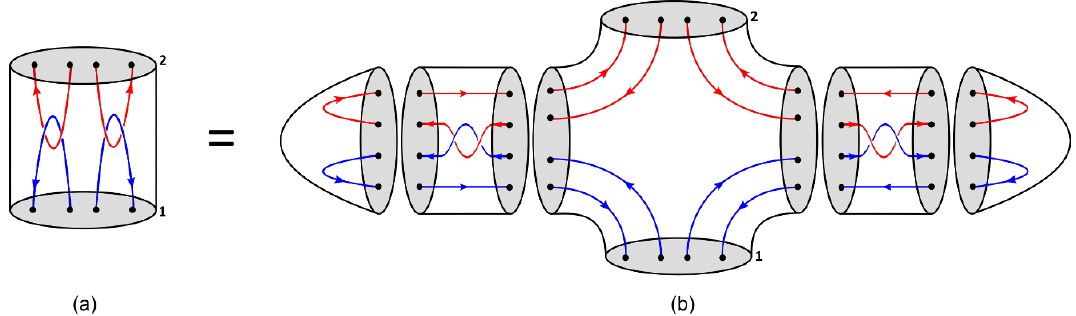
S 2 can be obtained by considering ∪